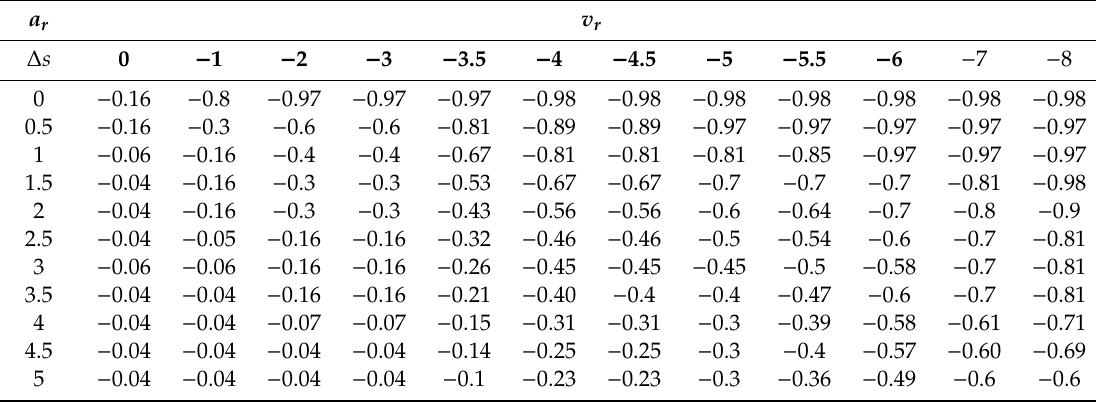
Table 7. Partial training